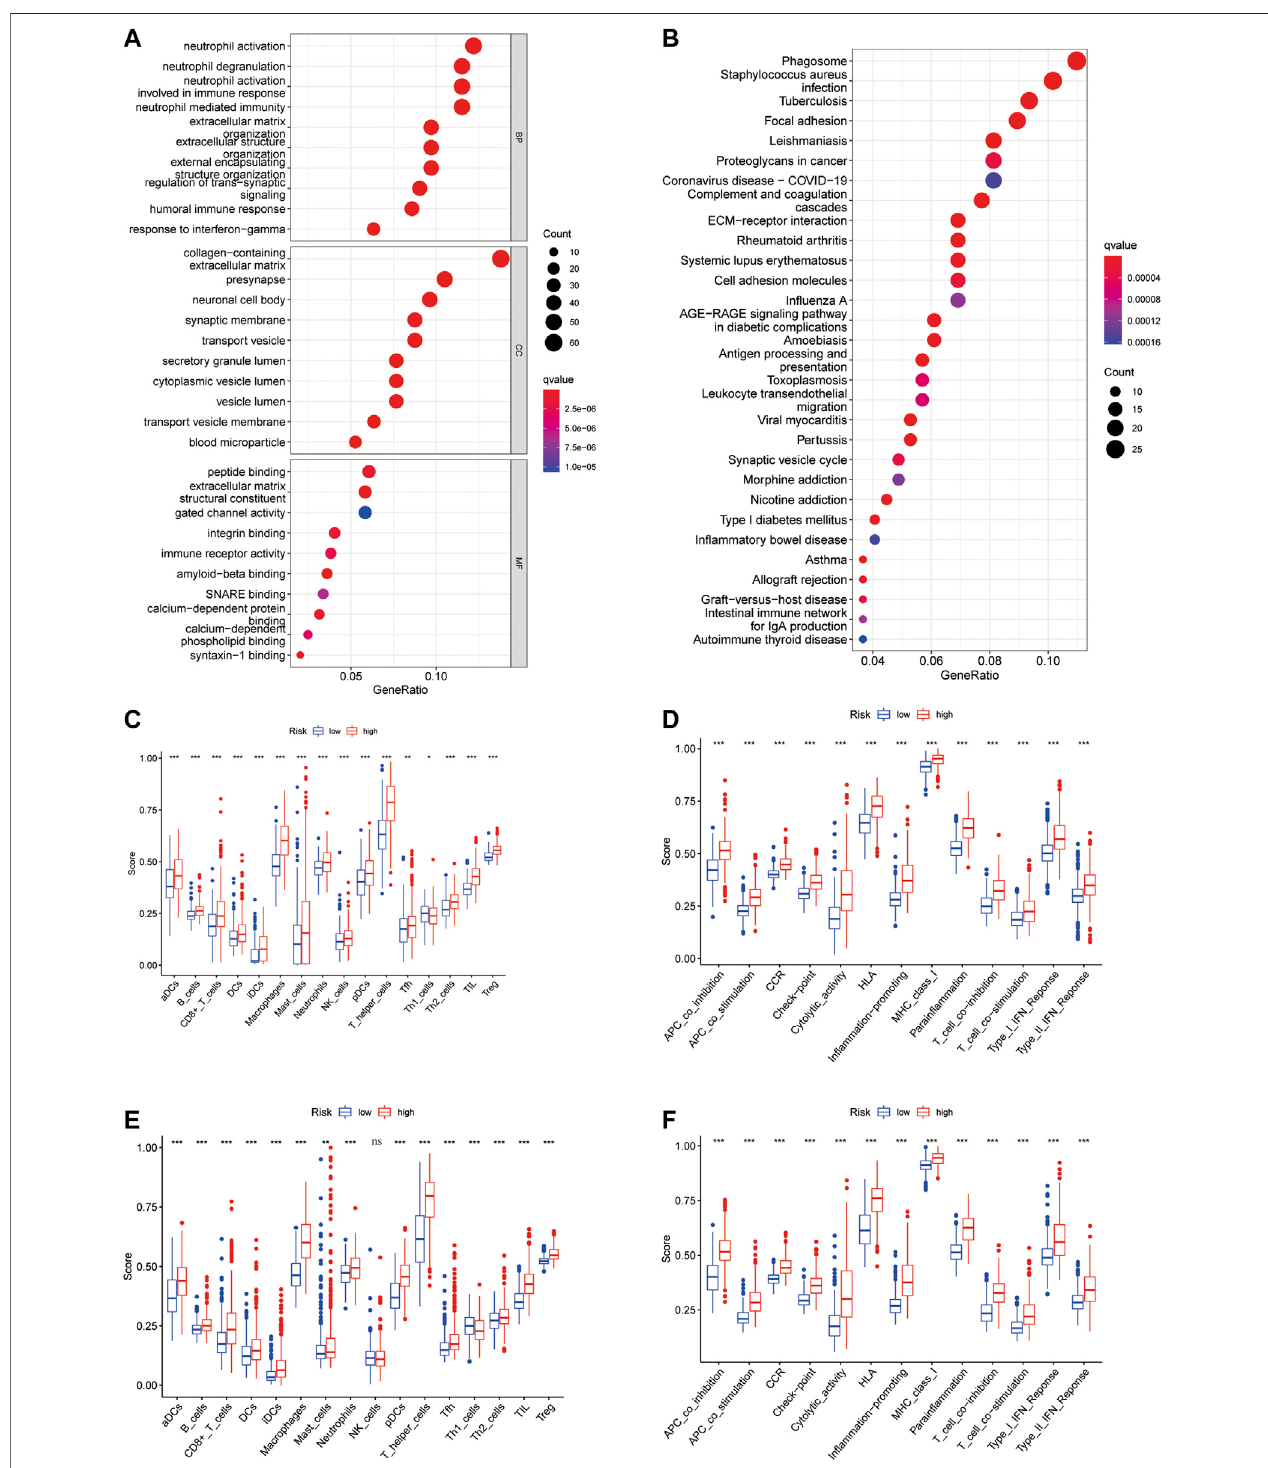
FIGURE 6 | Functional annotation enrichment analysis and comparison of immune cell in fi ltration between CR-Score subgroups. (A) GO functional enrichment analysis. (B) KEGG functional enrichment analysis. Bubble size and color correspond to the differentially enriched gene number and p -value for the signi fi cance of the enrichment. Boxplots of ssGSEA results for 16 immune cells (C) and 13 immune-related functions (D) in the TCGA cohort. The scores of 16 immune cells (E) and 13 immune-related functions (F) in the CGGA cohort. Data are shown as the mean ± SD; t test, * p < 0.05, ** p < 0.01 and *** p < 0.001 compared to the high-risk group in (C – F) ; ns, no signi fi